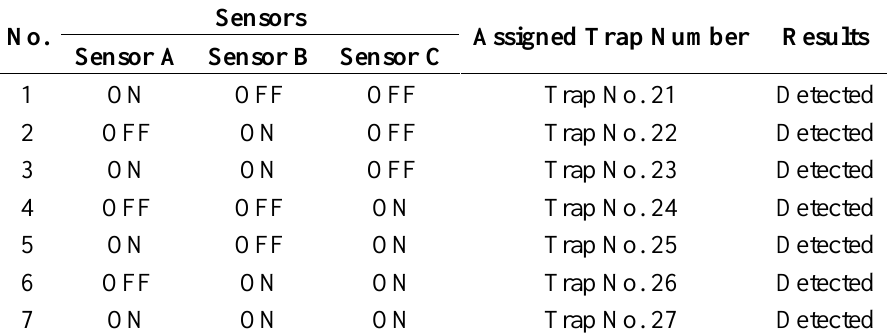
Table 2. Combination pattern for the bending sensors test and results.